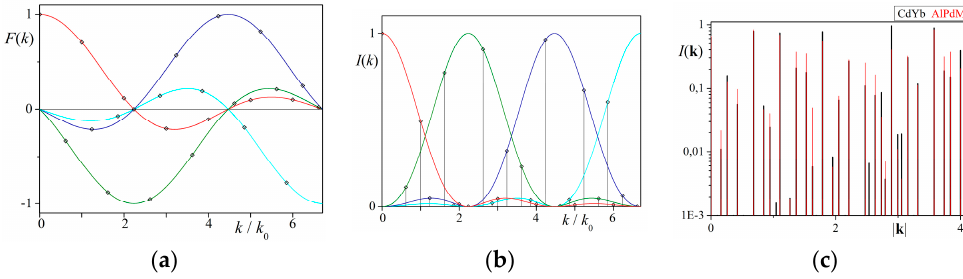
Figure 3. ( a ) Structure factor (cid:1832)((cid:1863)) calculated for the Fibonacci chain using formula (11) with first 4 envelopes m = { 0,1,2,3 } marked with different colors (red, olive, blue and cyan); ( b ) Diffraction pattern of the Fibonacci chain calculated as squared formula (11) with first 4 envelopes marked (notation from the left figure used). Peaks are distributed periodically within an envelope (period (cid:1863) (cid:2868) = (cid:2870)(cid:3095)(cid:3099) ≈ 4.54 [ a . u . ] ) and envelopes are deployed with periodicity k = k 0 = 2 πτ 2 5 k 0 ≈ 10.2 [ a . u . ] which is an incommensurate ratio relative to scaling factor τ ; ( c ) Exemplary diffraction pattern calculated using formula (13) along given direction in reciprocal space for the simple decoration of CdYb and AlPdMn icosahedral phase.